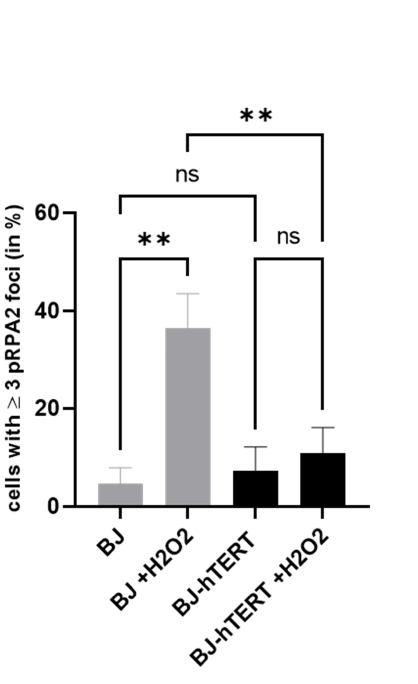
Figure 3. Evaluation of pRPA2 foci formation upon ROS-induced replication stress. ( Left ) The bar plot displays the impact of H 2 O 2 treatment on pRPA2 foci formation in BJ and BJ-hTERT cells. One-way ANOVA test was applied, followed by a Fisher’s LSD post hoc test, with a confidence interval of 95%. ( Right ) Representative images from BJ (top) and BJ-hTERT (bottom) treated with H 2 O 2 . A total of 180 cells were counted from n = 3 independent experiments. The representative pictures show DAPI-stained nuclei with nuclear pRPA2 foci (white arrow). ns ( p > 0.05), ** ( p ≤